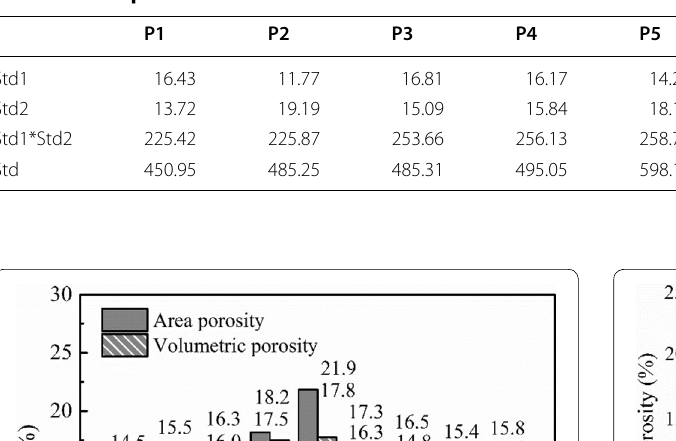
Table 7 The standard deviations of the histogram of the pixel coordinates of each pore centroid and the area of each pore of each specimen.